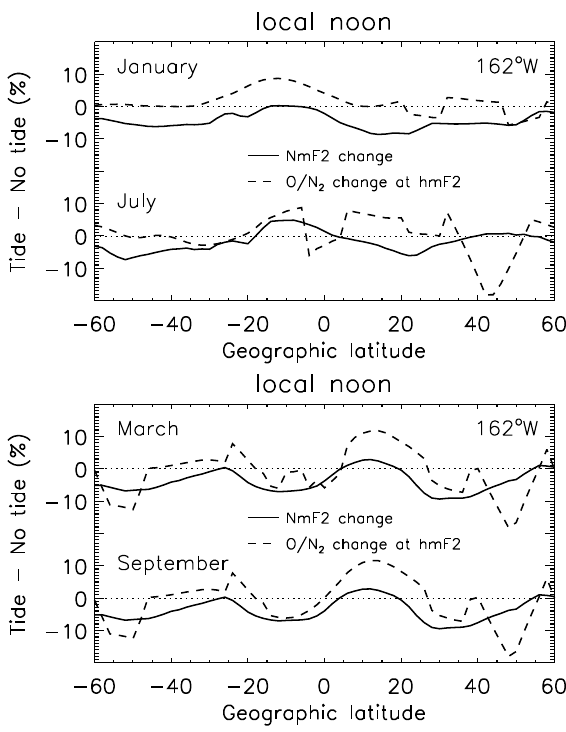
Fig. 7. As Fig. 6 for local